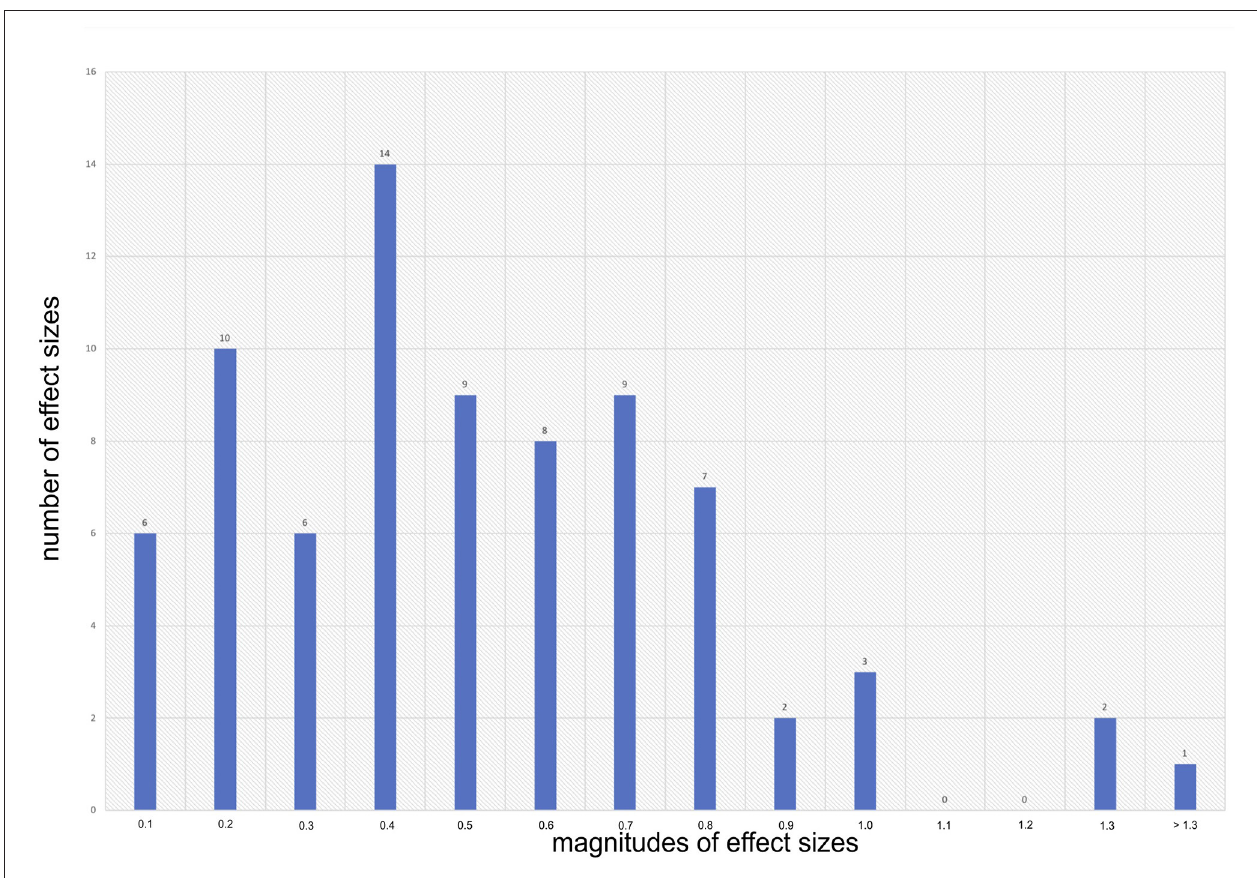
FIGURE 2 | Distribution of effect